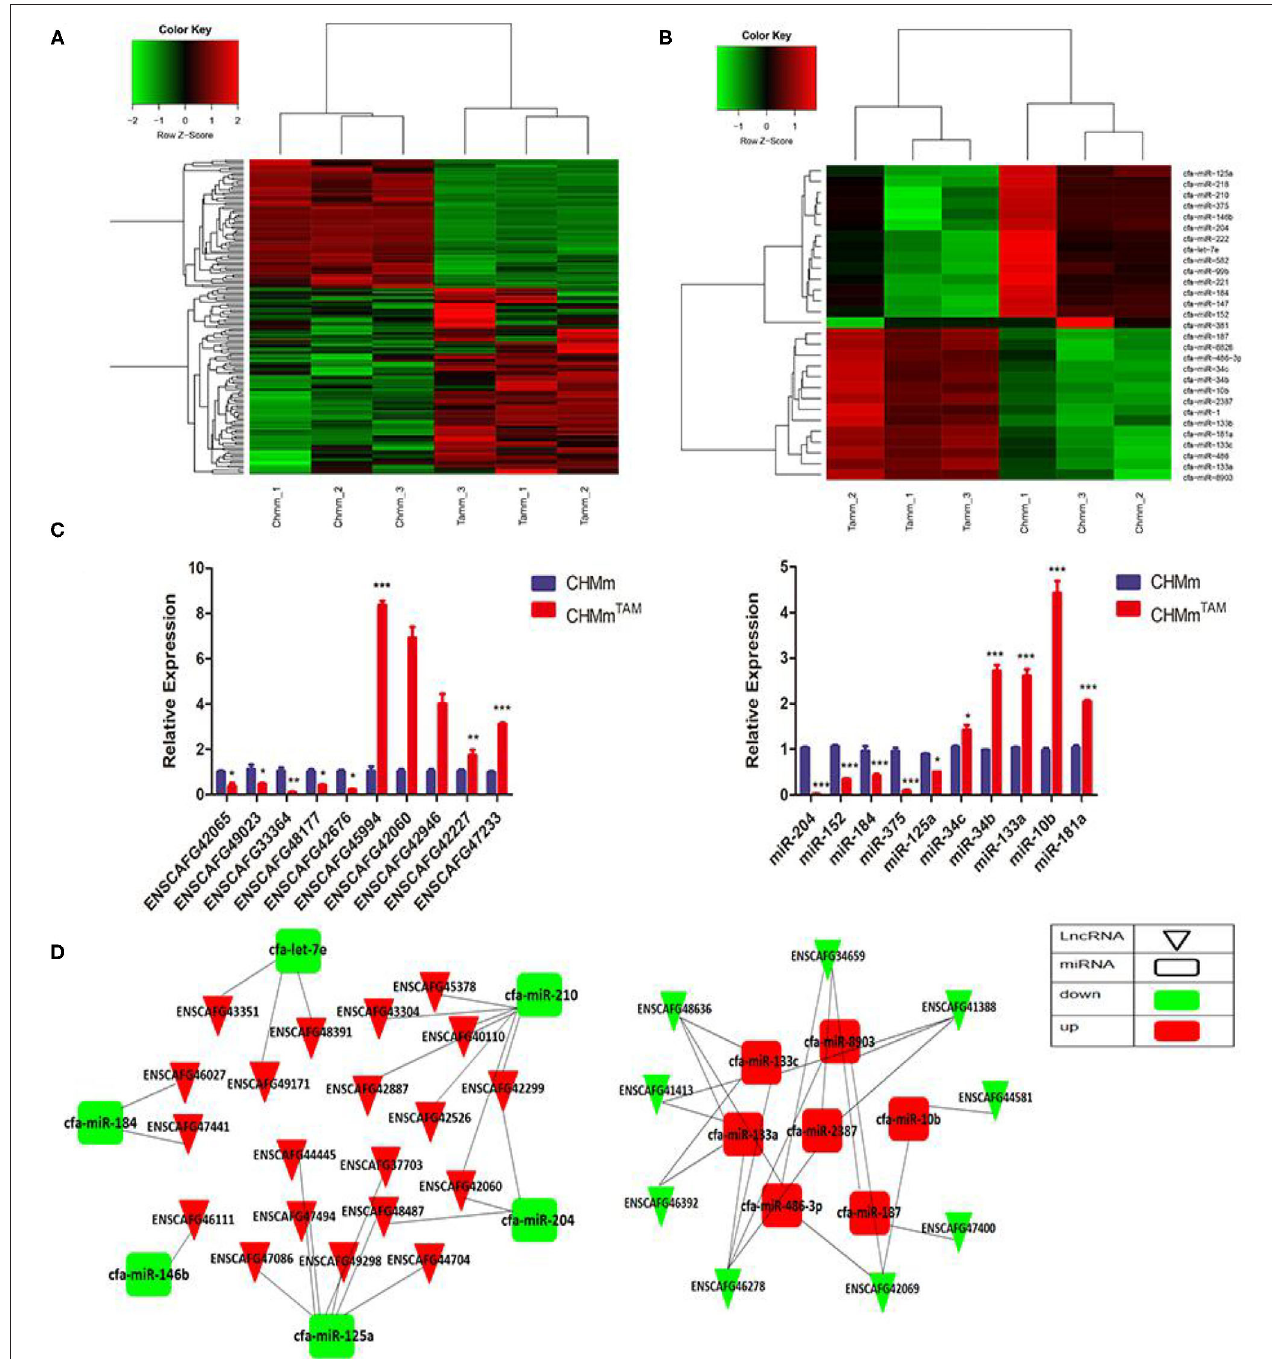
FIGURE 1 | LncRNAs and miRNAs are associated with TAMR in CMGTs. (A,B) RNA sequencing was used to detect differentially expressed lncRNAs and miRNAs in CHMm TAM and CHMm. (C) Expression of lncRNAs and miRNAs in CHMm TAM and CHMm by qRT-PCR. (D) lncRNA-miRNA interaction diagram. Data are presented as means ± SD of at least three independent experiments. Compared with control group, * P < 0.05, ** P < 0.01, *** P < 0.001.